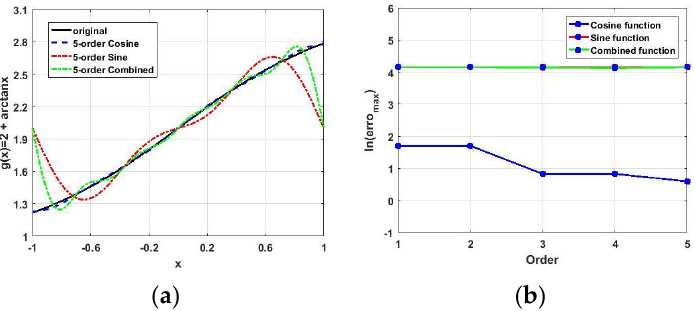
  f x Figure 4. Approximation of f ( x ) : ( a ) 5 order approximation of various basis functions; Figure 4. Approximation of : ( a ) 5 order approximation of various basis functions; ( b ) ( b ) Approximation error of various basis Approximation error of various basis functions.